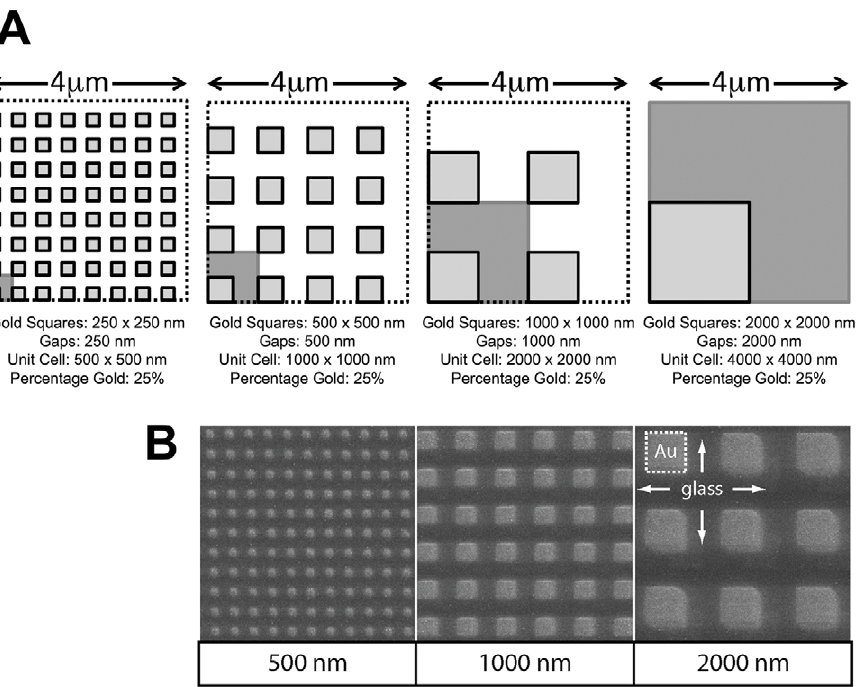
Figure 1. RGD-gold patterns produced by the nanostencil technique. (A) Design of the patterns. Gold squares of the indicated sizes were applied to glass surfaces (see Materials and Methods). Unit cells of the four individual patterns are shown in blue. Note that by keeping the width of the squares the same as their lateral spacing, the patterns were designed such that the surface of RGD-coupled gold was fixed to 25% of the total area. After manufacturing the patterns, RGD peptide was coupled to the gold squares to provide restricted and integrin-specific cell attachment, and intervening spaces were passivated with PLL-g-PEG. (B) SEM micrographs of patterns of gold squares (500 6 500 nm 2 , 1000 6 1000 nm 2 and 2000 6 2000 nm 2 ) on glass coverslips. The 250 6 250 nm 2 squares could not be imaged due to electron charging